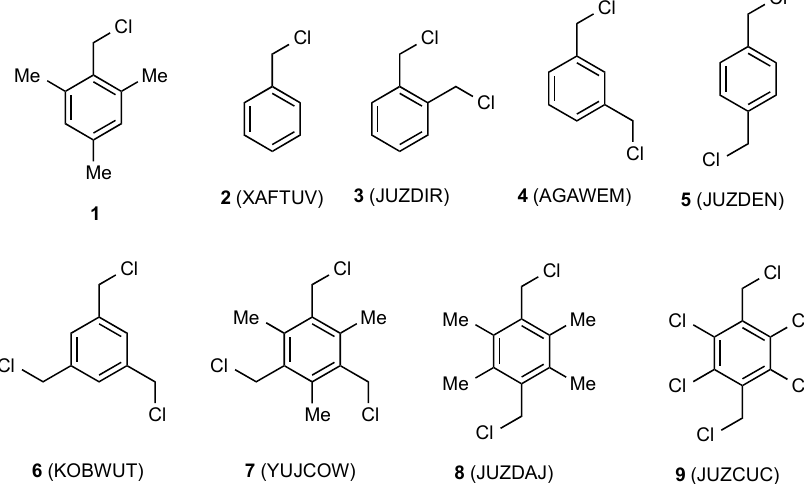
Figure 2. A survey of crystallographically characterised benzyl chlorides with CSD reference codes.